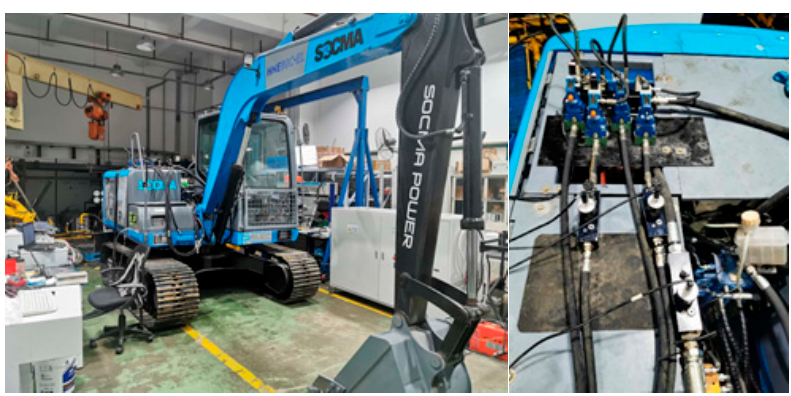
Figure 10. Structure of the experimental platform.